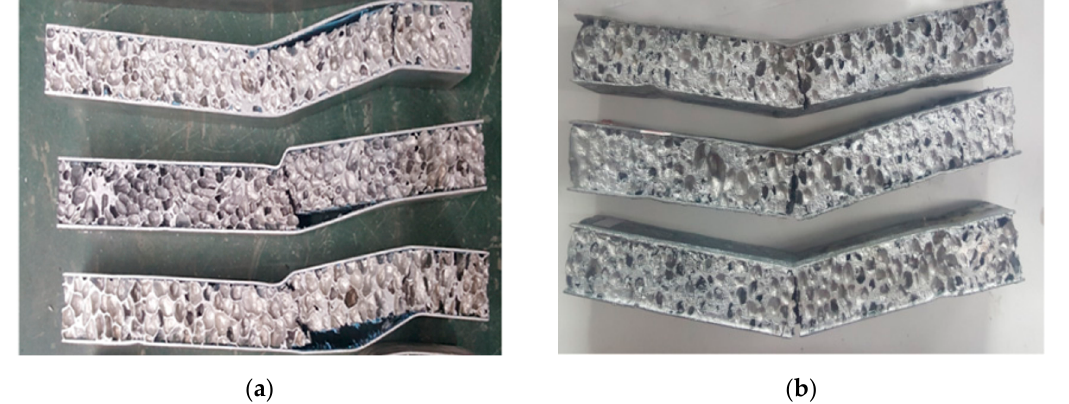
Figure 9. Fatigue fracture morphology of two types of AFS ( a ) adhesive joining samples ( b ) metallurgical joining samples.